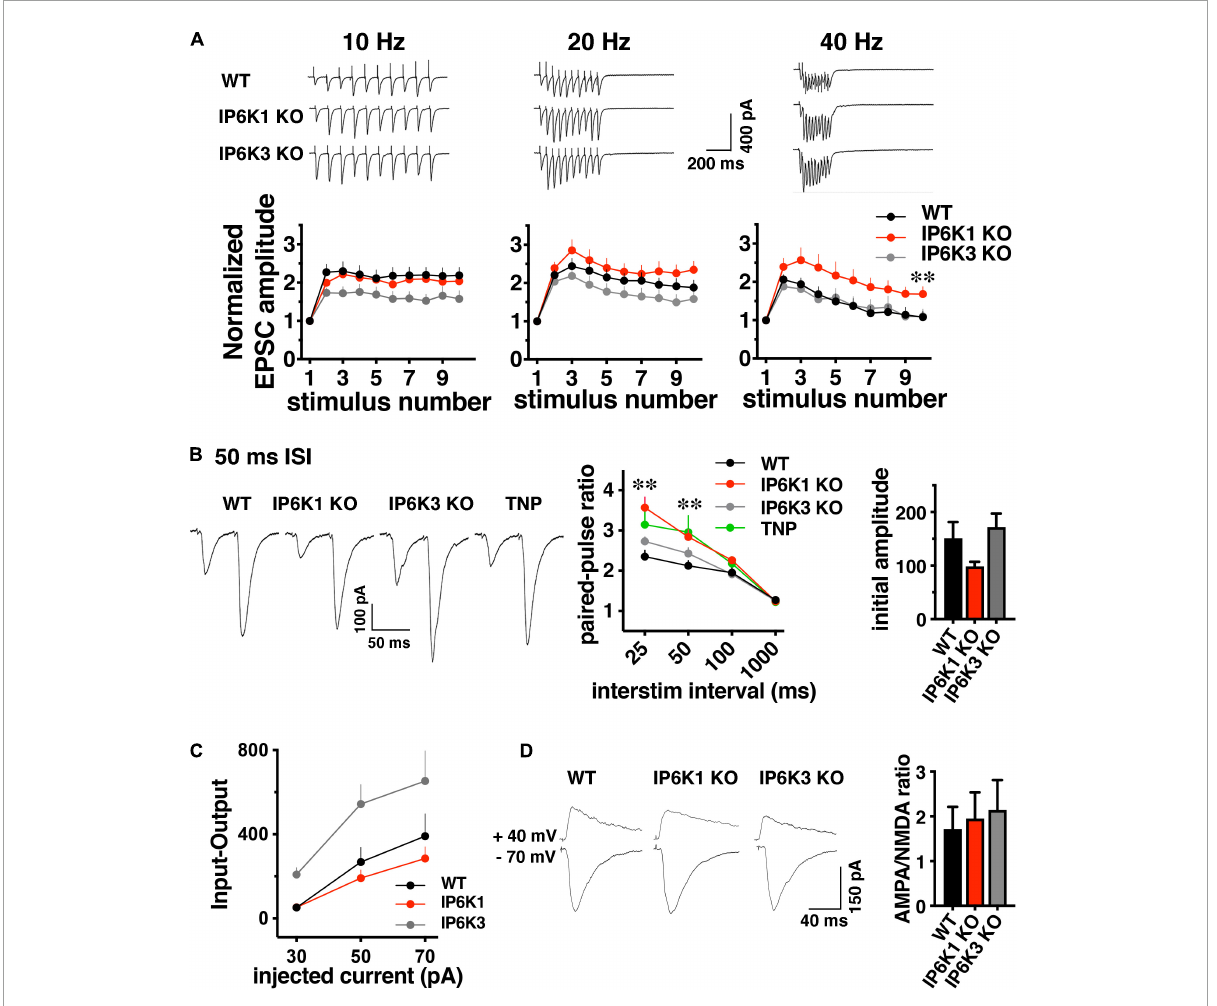
FIGURE5 Short-term facilitation in predominantly VGLUT1 expressing Schaffer collateral synapses. (A) Top: representative traces of EPSC trains evoked at 10, 20, and 40 Hz stimulation recorded at –70 mV in whole cell configuration. Bottom: normalized EPSC amplitudes show activity dependent facilitation of IP6K1 KO compared to WT at 40 Hz (* p < 0.05 and ** p < 0.01). Data are means ± SEM from n = 9–11 cells. (B) Left: representative examples of postsynaptic responses induced by pairs of depolarization-evoked action potentials (50 ms apart) in the presynaptic cell. Stimulus artifacts are blanked. Middle: summary plot of paired pulse ratio (PPR) calculated at 25, 50, 100, and 1000 ms ISI in the same cells, showing higher facilitation at shorter ISIs. Deletion of IP6K1 (red) increases paired pulse facilitation, compared to WT (black, * p < 0.05 and ** p < 0.01). Treatment with the IP6K inhibitor TNP is similar to IP6K1 KO ( n = 8–11, p > 0.05). Right : initial EPSC amplitudes in paired-pulse. (C) Input-output curve demonstrating EPSC amplitudes at different current intensities ( n = 4–8). (D) Left: representative traces of AMPA and NMDA receptor mediated EPSCs. Right: quantitation indicates no significant differences in AMPA/NMDA ratio between WT and IP6K KO mice ( n =